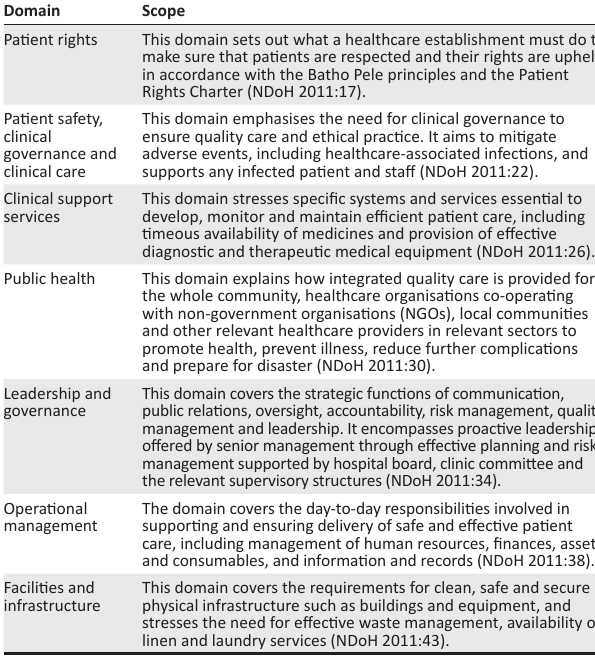
TABLE 1: The National Core Standards’